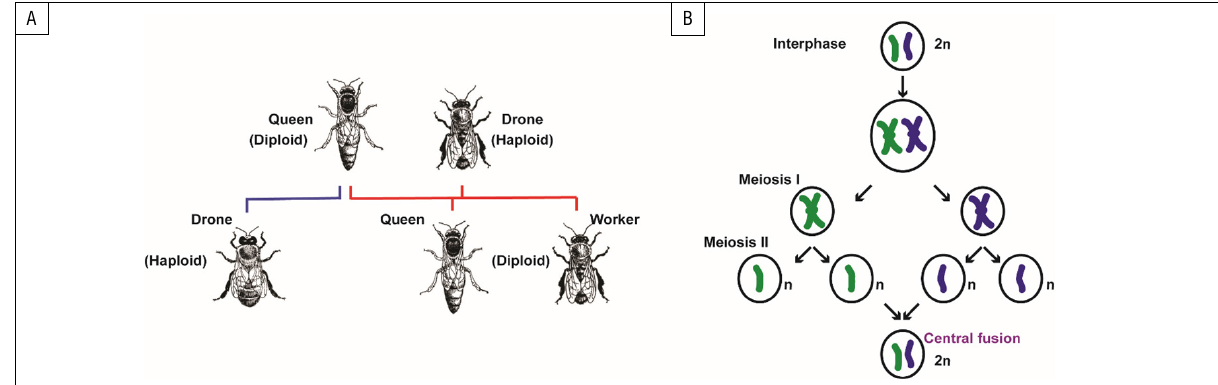
Figure 3: Sex determination by haplodiploidy as described by Johann Dzier ż o ń in 1845 where (A) unfertilised (haploid) eggs become drones while fertilised eggs become workers or queens. However, the diploid state can be restored in thelytokous parthenogenesis (B), through the fusion of the two central pronuclei in meiosis II, as happens in the laying workers of Apis mellifera capensis , leading to emergence of females from unfertilised eggs, thus being an exception to Dzier ż o ń ’s